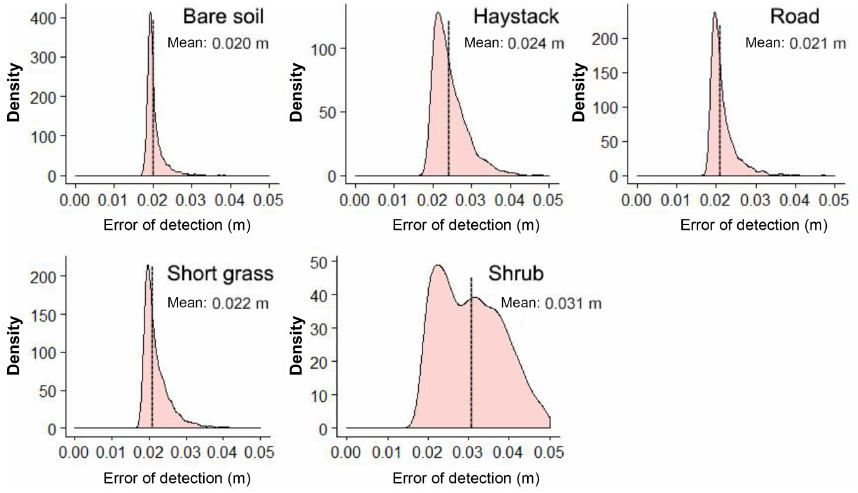
Figure A1. Distribution of the propagated error derived from Monte Carlo simulation (datasets: F3_a and F3_b of DSLR surveys; surface classification shown in Fig. 1c).